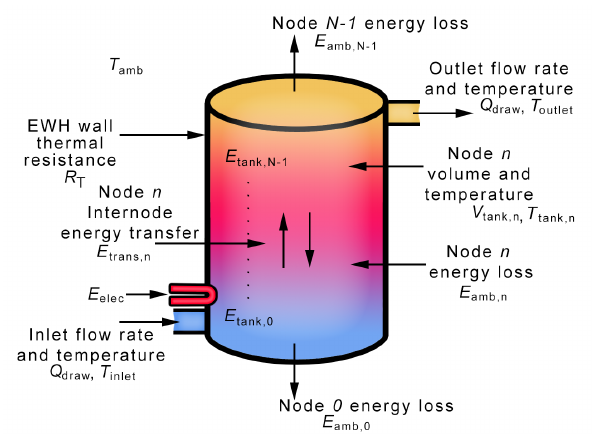
Figure 1. Energy flow, thermal resistance, flow rate, temperature, and volume in a multi-node EWH. When water is drawn from the tank, the water leaves through the outlet pipe at the temperature of the uppermost node N − 1. This water is replaced with cold